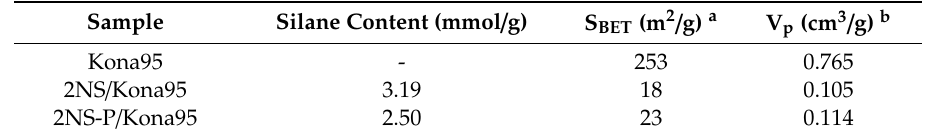
Table 1. Textural properties of the support and amine-functionalized silica from N 2 sorption isotherms at − 196 °C.